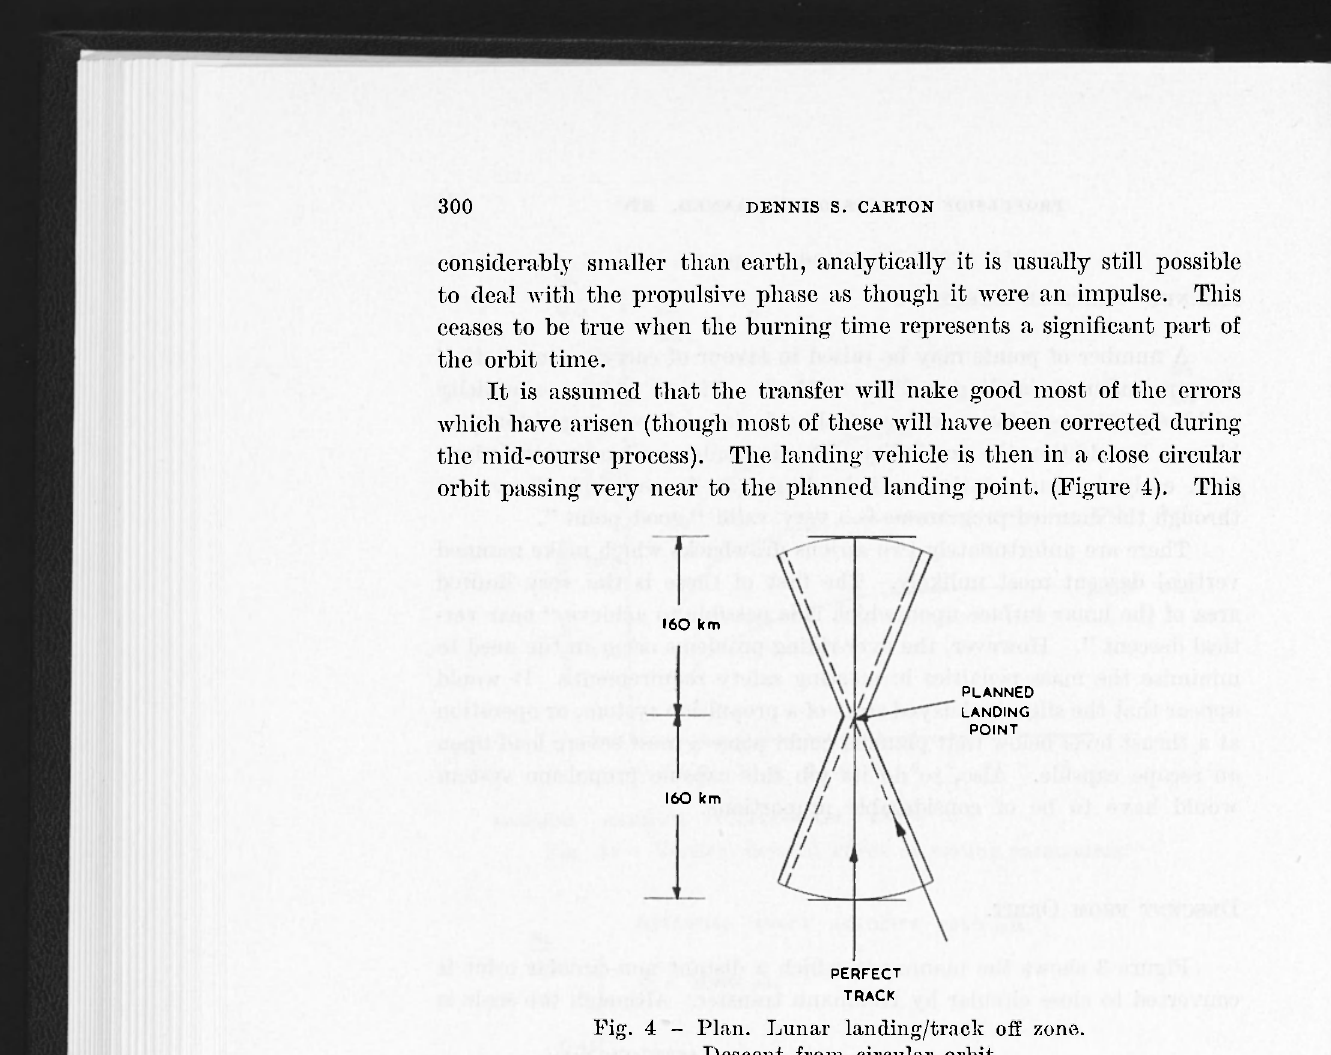
Fig. 4 - Pian. Lunar landing/track off zone. Descent from circular